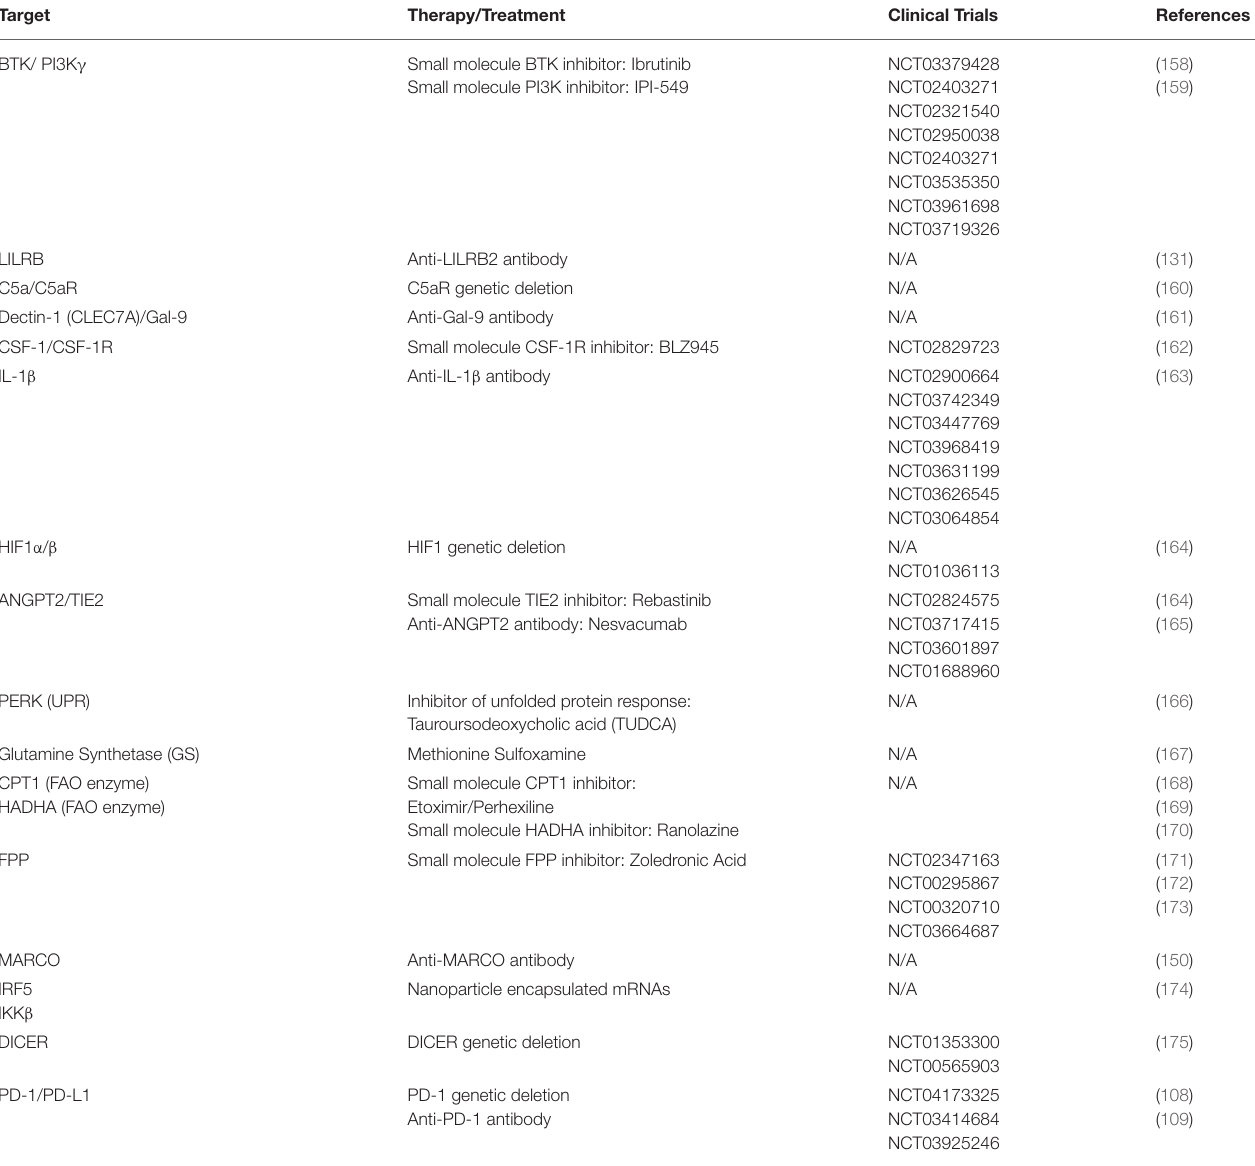
TABLE 3 | Therapies used to reprogram tumor associated macrophages and